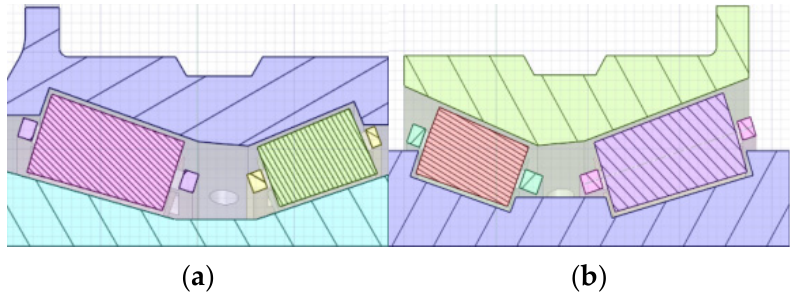
Figure 6. Simplified double-row TBR models. ( a ) Outer ring rib structure; ( b ) Inner ring rib structure.